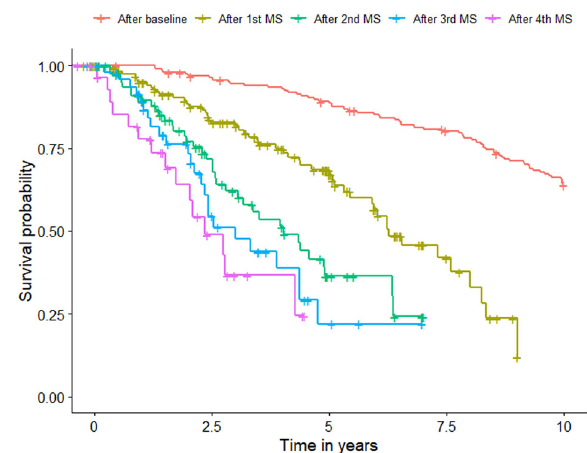
Fig. 2 Kaplan – Meier curves for survival after cumulative clinical milestones occurrence. Here we display the survival curves for the presentation of clinical milestones (MS) cumulatively. The red curve represents the complete cohort ’ s survival and is included as a reference. The curve labels represent the cumulative presentation of the clinical